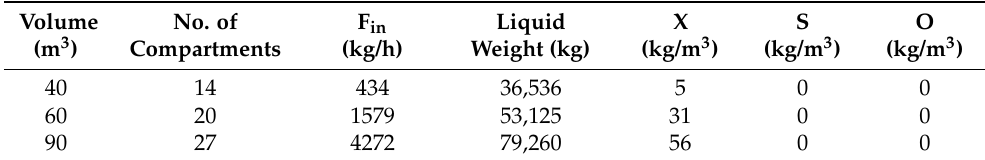
Table 2. Initialization parameters for the compartmental